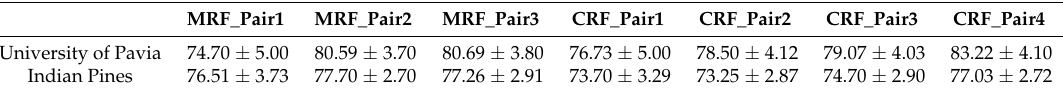
Table 4. Pairwise Fusion classification accuracies [%] using different pairwise decision